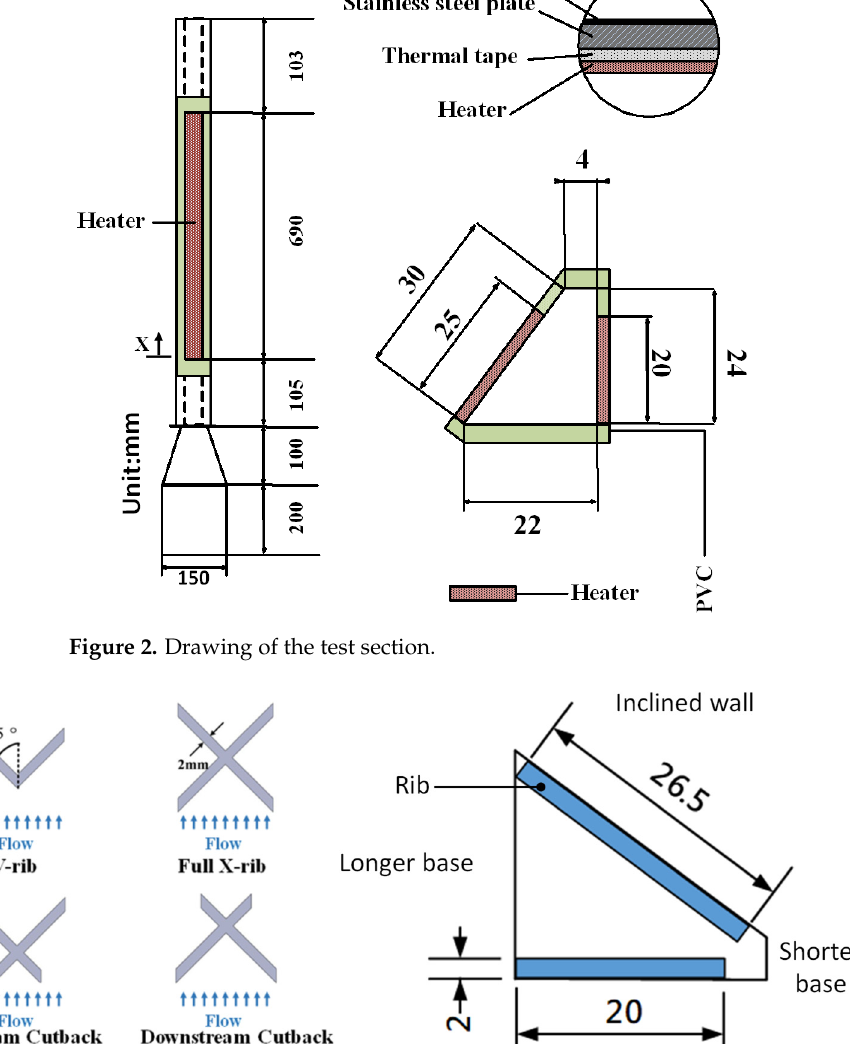
Figure 2. Drawing of the test section.